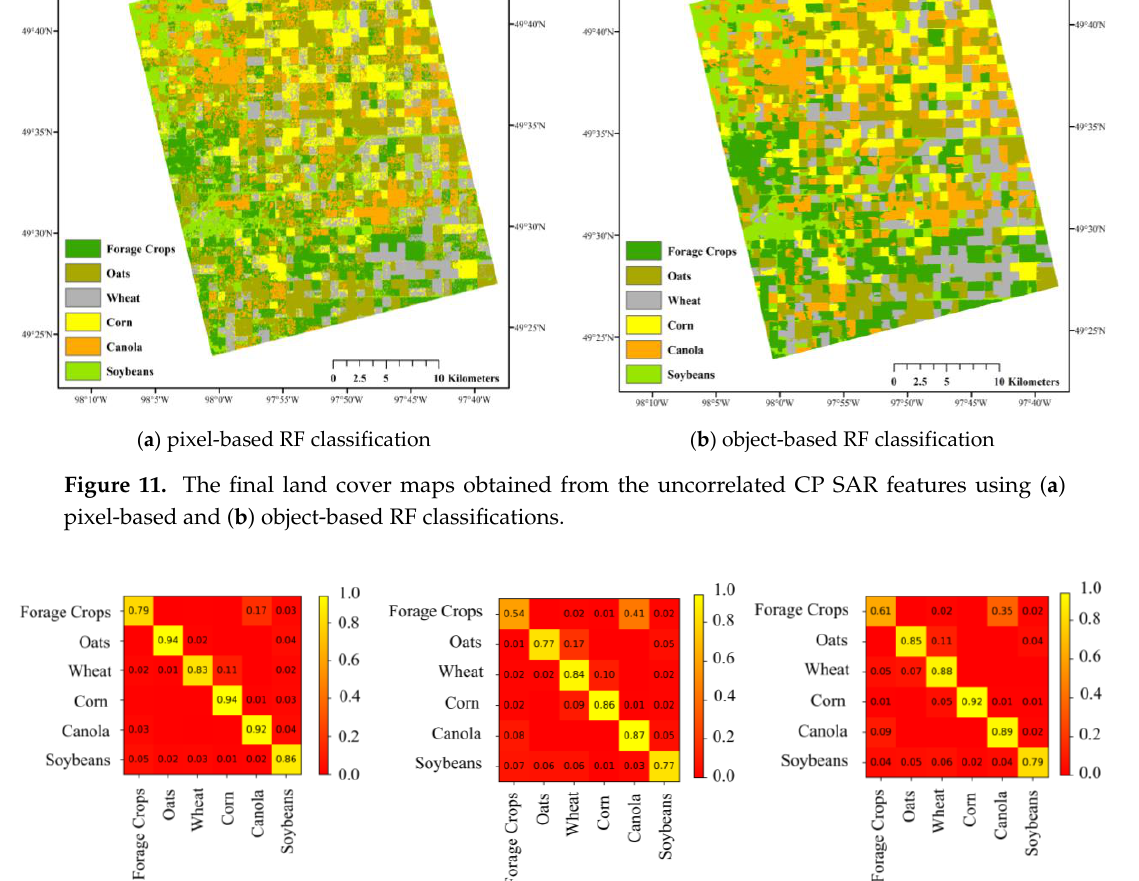
Figure 12. The confusion matrices for the final classification maps with the object-based RF classification using the uncorrelated features extracted from ( a ) FP, ( b ) DP, and ( c ) CP SAR data.